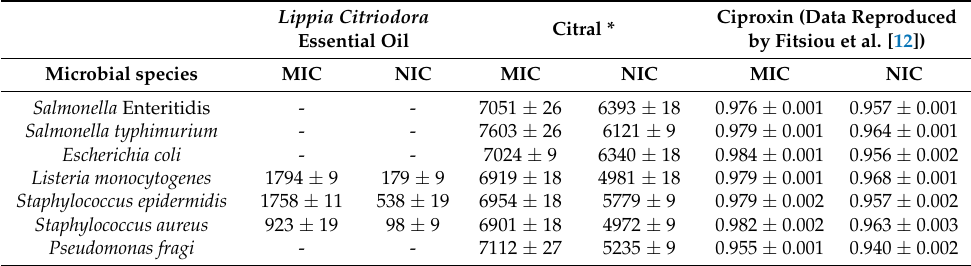
Table 3. MIC and NIC ( µ g/mL) of Lippia citriodora essential oil and citral against common food spoilage and pathogenic bacteria. Ciproxin was used as control.